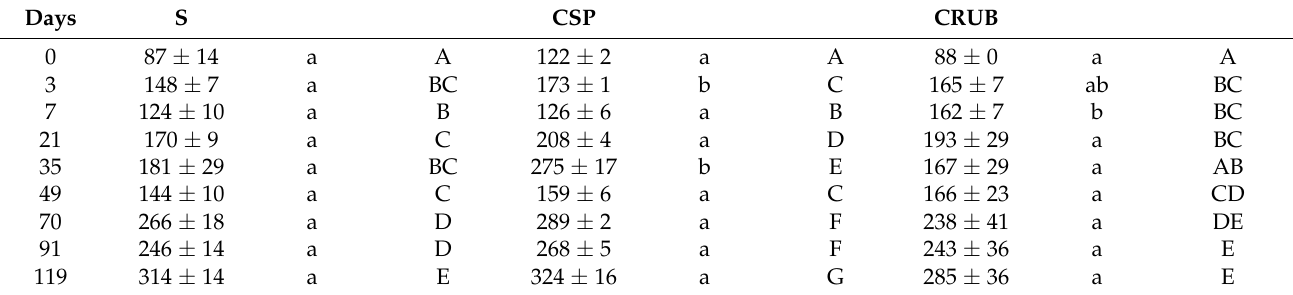
Capital letters indicate significant differences among sampling dates and small letters among treatments ( p < 0.05). S: soil control, CSP: poultry manure and wheat straw; CRUB: biosolids and wood shavings. Values ± represent standard deviations of the mean values. Table 4. Effect of incubation days on the evolution of NO 3 − -N (mg NO 3 − kg − 1 ) in the soil S2 amended with the different composts.